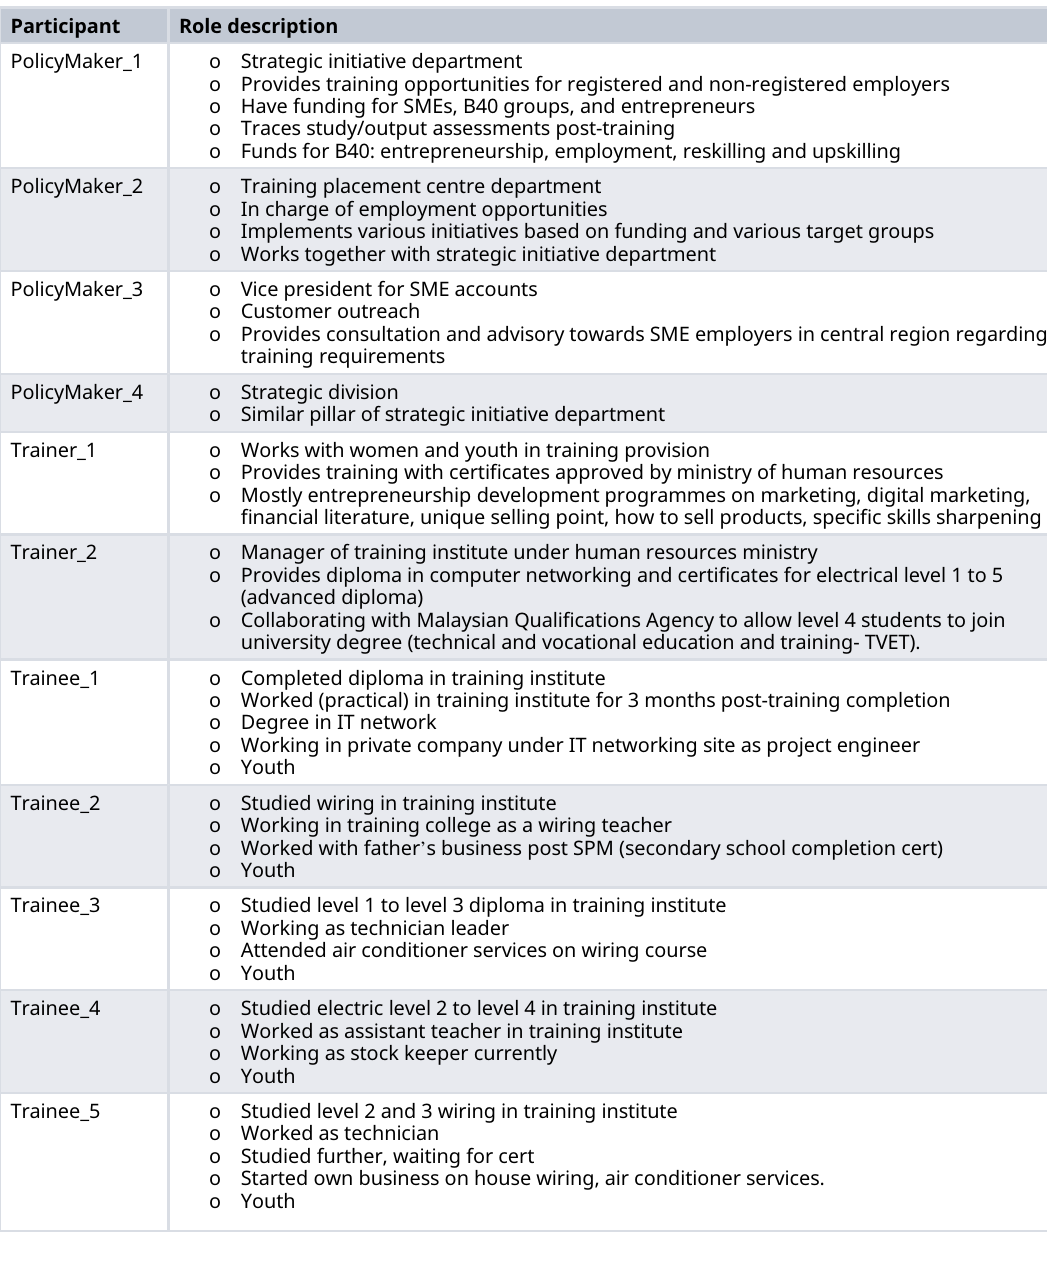
Table 3. Demographic details of interview participants.